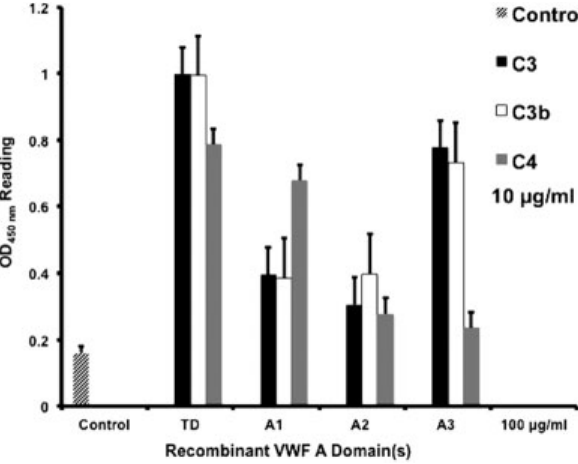
Fig. 3 Puri fi ed human C3 and C3b bind predominantly to recombi- nant human VWF A3, and puri fi ed human C4 binds predominantly to recombinant VWF A1. 100 μ g of each VWF A domain were mixed separately with 10 μ g/mL of either C3, C3b, or C4, and incubated at 4°C overnight. The mixtures were pipetted into microwells containing immobilized rabbit anti-His antibody, and incubated for 2 hours at 37°C. The wells were washed and the quantity of C3 or C4 bound to each domain was determined using either goat anti-human C3 or C4 antibodies, as described in ► Fig. 2 ( n ¼ 7). Mixtures of recombinant human VWFA1A2A3 (TD) were used as positive controls. The negative control was phosphate-buffered saline (PBS)/bovine serum